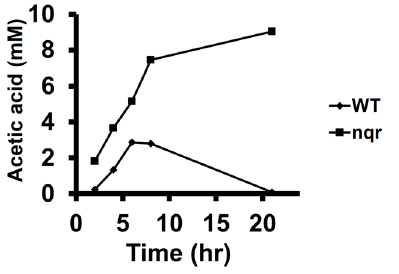
Table S1 Phenotypes of the V. cholerae D nqrA-F mutant